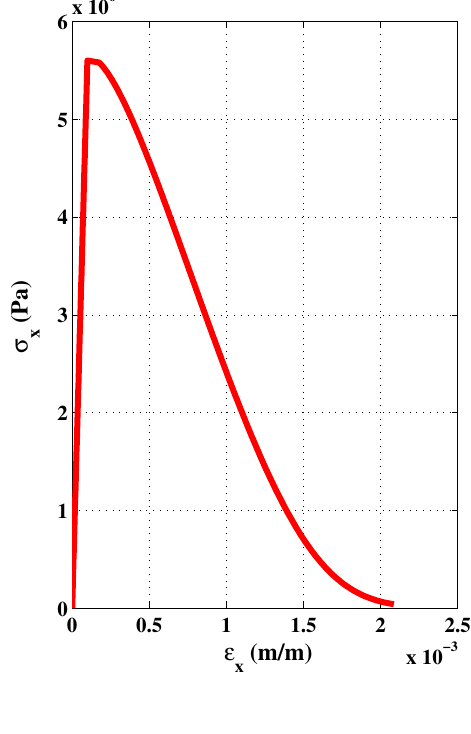
Figure 15. Stress-strain curve from numerical triaxial tension